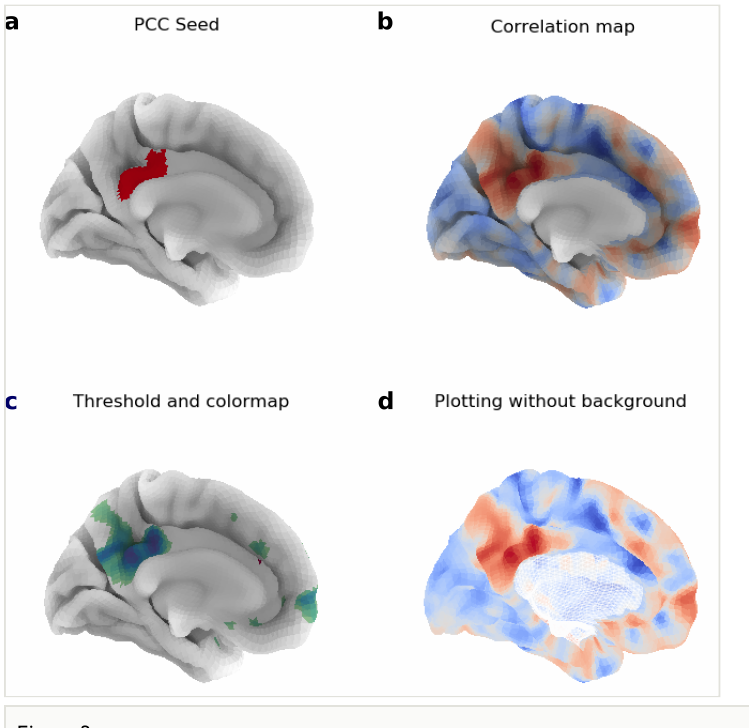
Figure 2. Seed-based functional connectivity example. a Seed region in the posterior cingulate cortex (PCC). b Pearson product-moment correlation coe ffi cient from the seed region time series to all other nodes. c The same map as in b, thresholded and plotted with a di ff erent colour scheme. d The same map as in b, plotted without sulcal depth information for